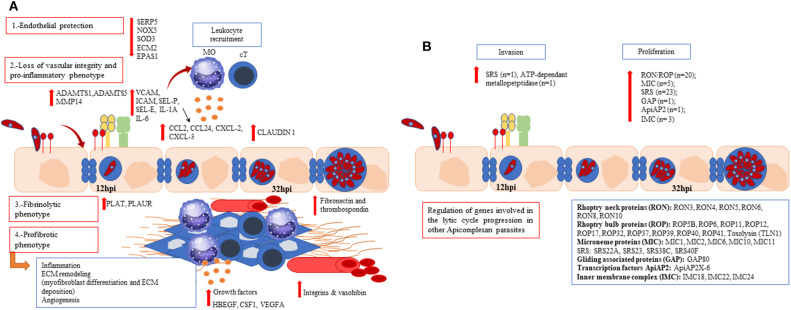
Graphical abstract with the main findings of up- and down-regulated host (A) and parasite (B) pathways/genes during an in vitro Besnoitia besnoiti infection in primary bovine endothelial cells. (A) A progressive endothelial dysfunction along the parasite lytic cycle is evidenced. Bos taurus differentially expressed genes are associated with reduced endothelial protection (SOD3, NOX5, ECM2, EPAS1, SERPIN5); a proinflammatory, fibrinolytic and profibrotic phenotype represented by cytokines (IL-1A, IL-6), chemokines (CXCL-2, CXCL-3, CCL-2, CCL24), surface adhesion markers (ICAM-1, VCAM-1, SELE, SELP), genes involved in the coagulation cascade (PLAT, PLAUR) and growth factors (HBEGF, CSF-1; VEGFA) for both post-infection times assayed. (B) Genes coding for surface proteins (SRS), microneme proteins (MIC), AP-2 transcription factors, rhoptry kinases (ROP), rhoptry neck proteins (RON), and genes coding for proteins such as apical membrane antigen-1 (AMA-1) and gliding associated proteins (GAP) were regulated along B. besnoiti lytic cycle. Mo, macrophages; cT, cytotoxic T lymphocytes.